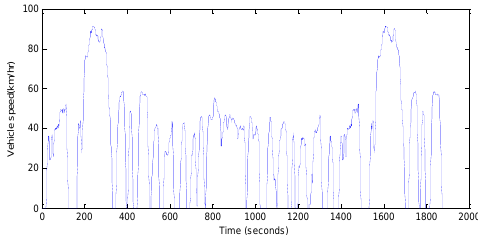
Figure 2. US EPA FTP75 urban driving cycle.